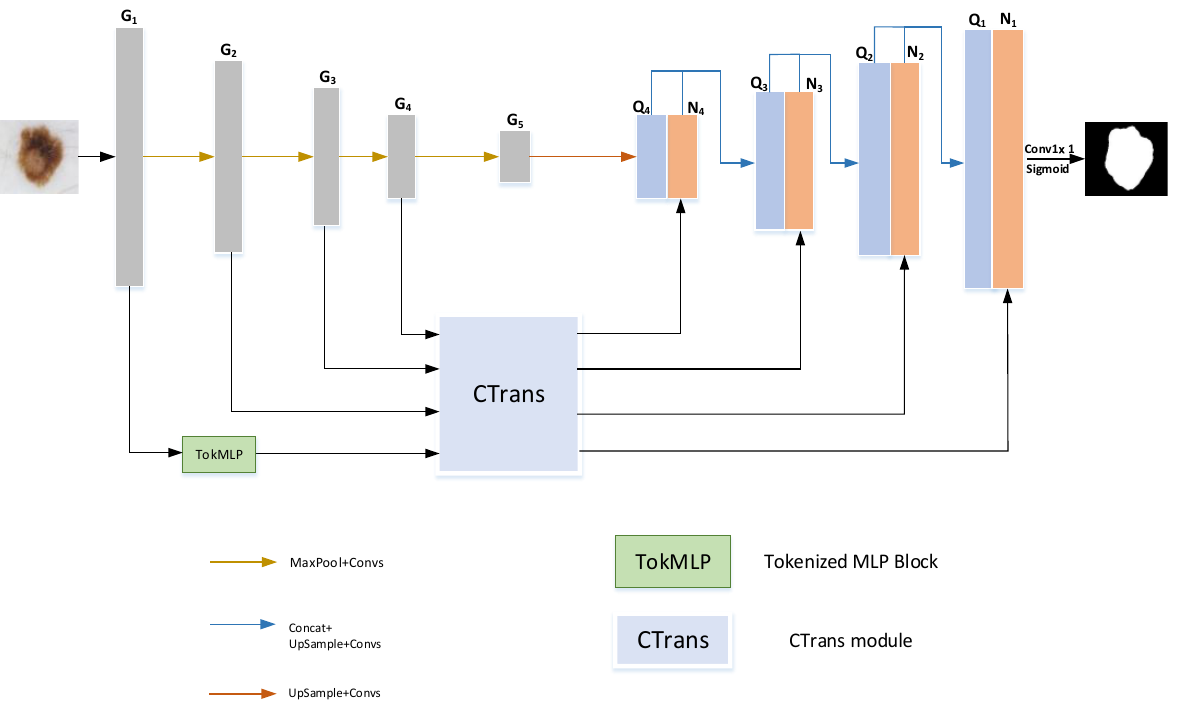
Figure 1. HMT network architecture.